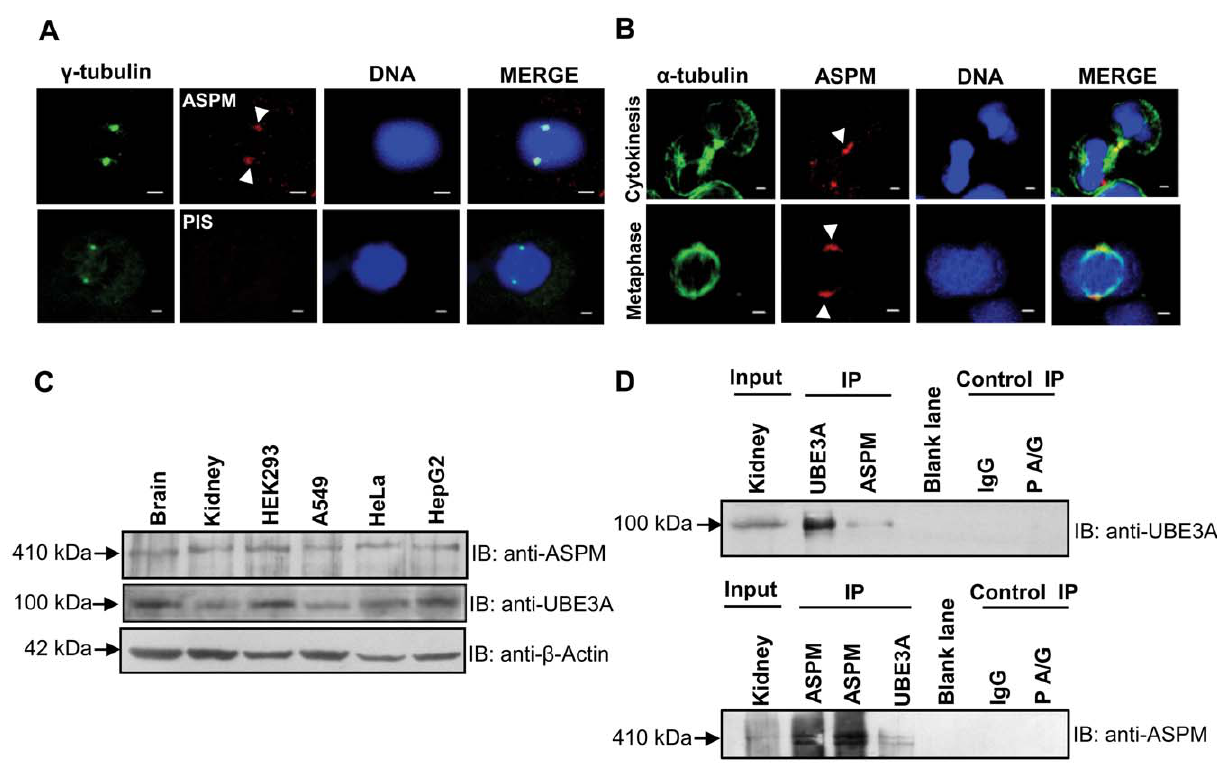
Figure 2. Localization of ASPM and interaction of ASPM with UBE3A invivo . (A) Indirect immunofluorescence of HEK293 cells stained with anti- c -tubulin and raised anti-ASPM antibodies. Upper panel: Note ASPM (red) colocalizes with the centrosomal marker c -tubulin (green). Lower panel: Pre-immune serum (PIS/normal IgG) does not show any signal. Scale bar=2 m m. (B) Immunofluorescence images of HEK293 cells stained with anti- a -tubulin and raised anti-ASPM antibodies. Upper panel: note ASPM localizes at midbody during cytokinesis (arrow heads). Lower panel: note ASPM localizes at spindle poles during metaphase (arrow heads). Scale bar=2 m m. (C) Expression profile of ASPM and UBE3A by Western blot analysis using lysates from human fetal brain, human fetal kidney, HEK293, A549, HeLa and HepG2. Anti-ASPM and anti-UBE3A (anti-UBE3A-sc-8926) antibodies recognize 410 kDa and 100 kDa bands, respectively. Note the ubiquitous expression of both proteins. (D) Co-immunoprecipitation of ASPM and UBE3A in human fetal kidney tissue. Upper panel: immunoprecipitation of ASPM co-precipitates UBE3A (100 kDa). Lower panel: immunoprecipitation of UBE3A co-precipitates ASPM (410 kDa). Input lane represents tissue lysate used in pulldown. None of these proteins coprecipitated with either normal IgG or PA/G beads. Abbreviations: IB, immunoblotting; and, IP, immunoprecipitation.